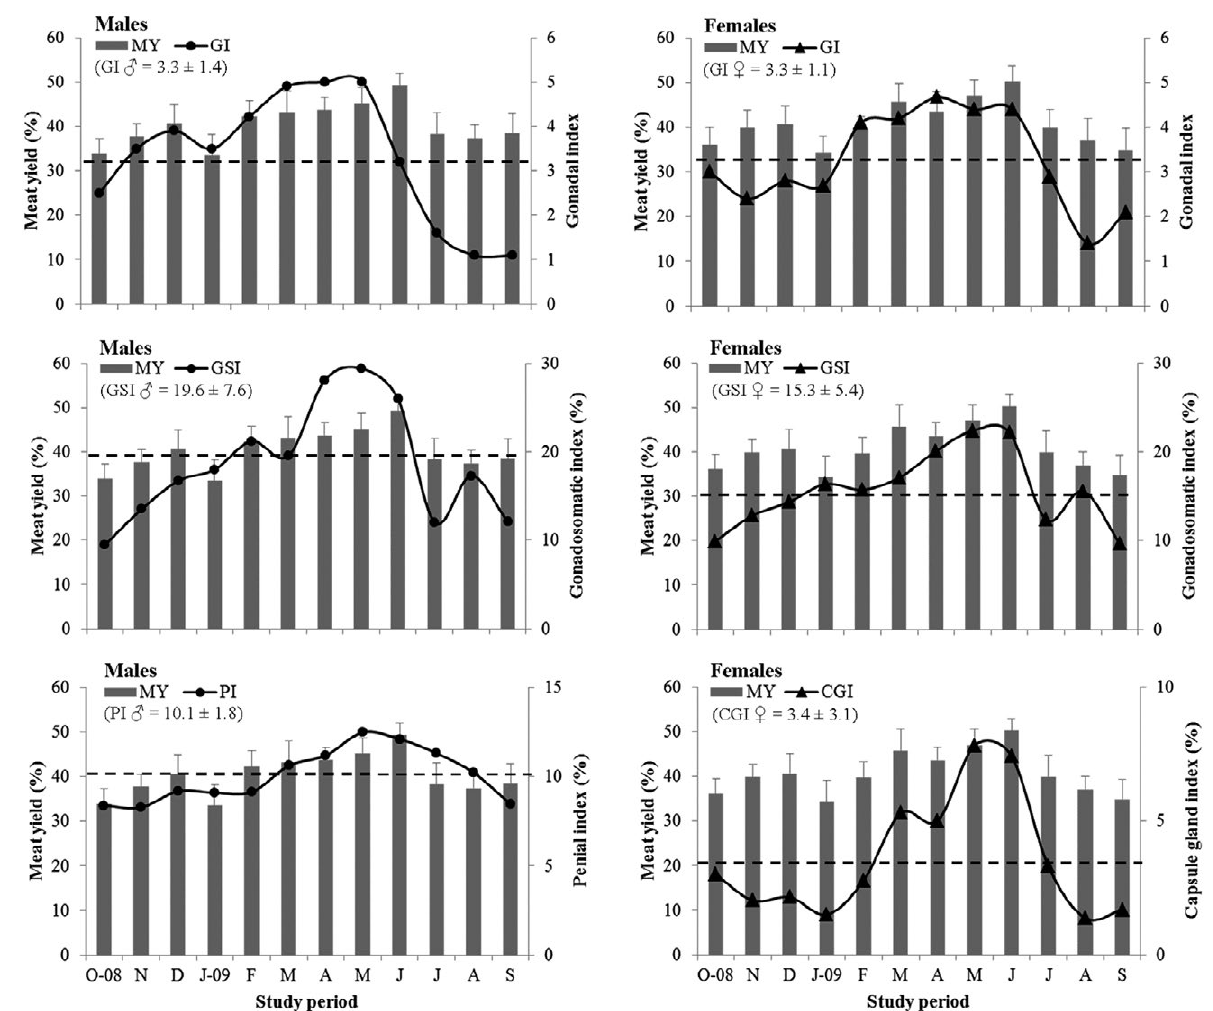
Fig. 6. – Influence of diverse indicators of the reproductive status of Bolinus brandaris males and females on the respective MY during the study period (October 2008 - September 2009). Interrupted lines denote average gonadal index, gonadosomatic index, penial index and capsule gland index